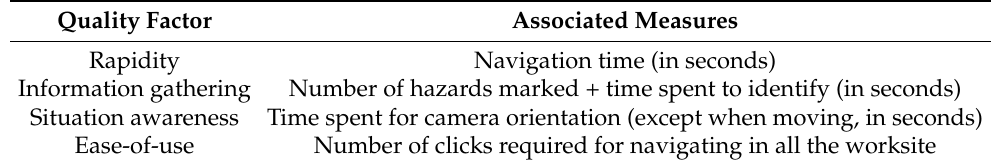
Table 1. Quality factors and measures for navigation interaction during hazard identification task. Quality